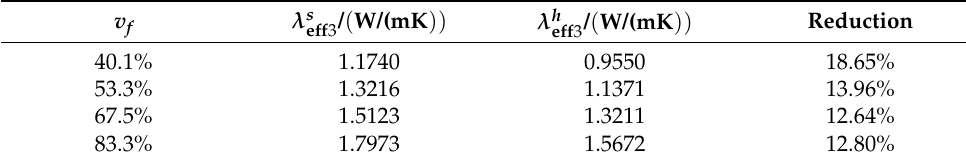
Table 6. Thermal conductivity of RVE 3